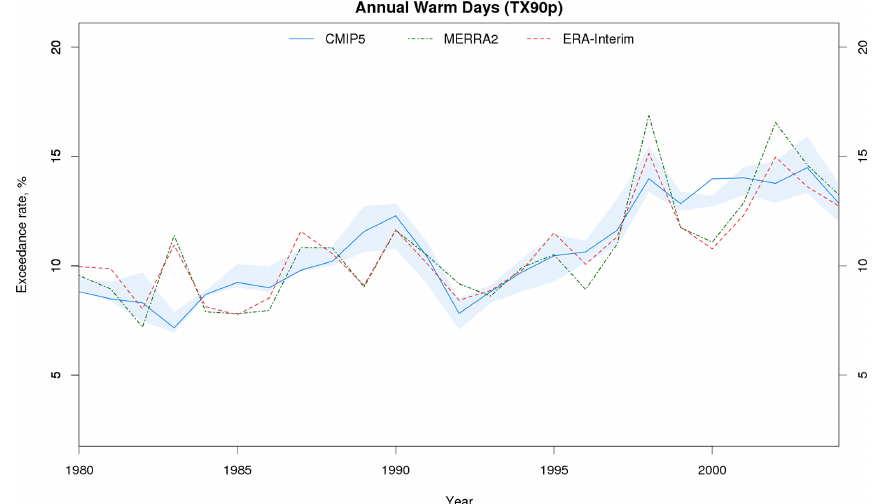
Figure 6. Time series plot of the annual percentage of days when the daily maximum temperature is higher than the 90th percentile for the respective calendar day. Percentile thresholds are calculated following Zhang et al. (2005b) for the base period 1980–2004. The shading indicates the interquartile ensemble spread (range between the 25th and 75th quantiles). The CMIP5 ensemble mean (blue line, five models in this example) averaged over all land grid boxes is compared with the reanalysis datasets MERRA-2 (green dashed line) and ERA-Interim (red dashed line). Similar to Fig. 9.37 e of IPCC AR5 (Flato et al., 2013) and produced with recipe_extreme_events.yml ; for details see Sect.